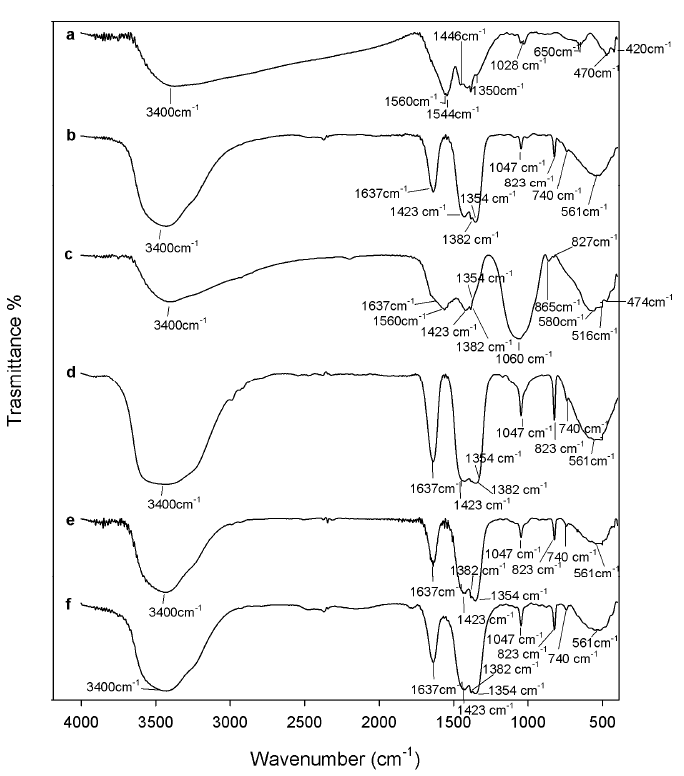
Figure 1. Fourier transform infrared spectroscopy (FTIR) of ( a ) ZrO 2 ; ( b ) hydroxyapatite (Hap); ( c ) 9ZrO 2 · 1Hap; ( d ) 7ZrO 2 · 3Hap; and ( e ) 5ZrO 2 · 5HAp gels, heated to 120 ◦ C and ( f ) Ca(NO 3 ) 2 4H 2